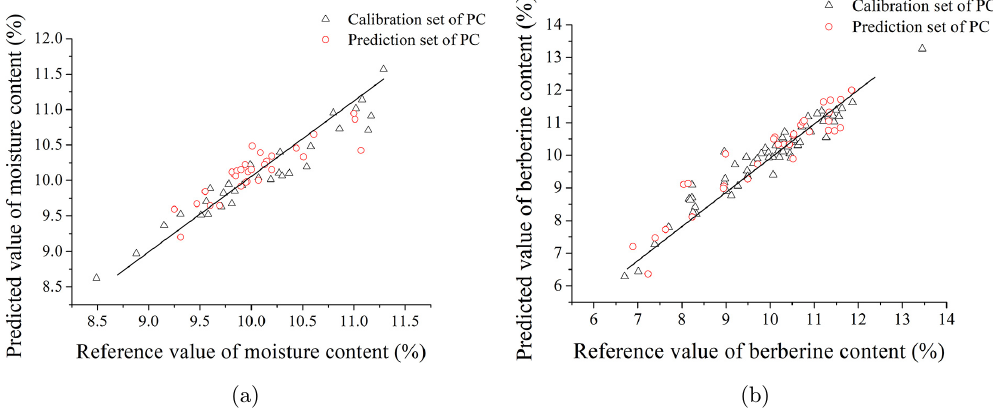
Fig. 9. Correlation diagram between NIRS predicted values and reference values of PC model. (a) Moisture content and (b) Berberine